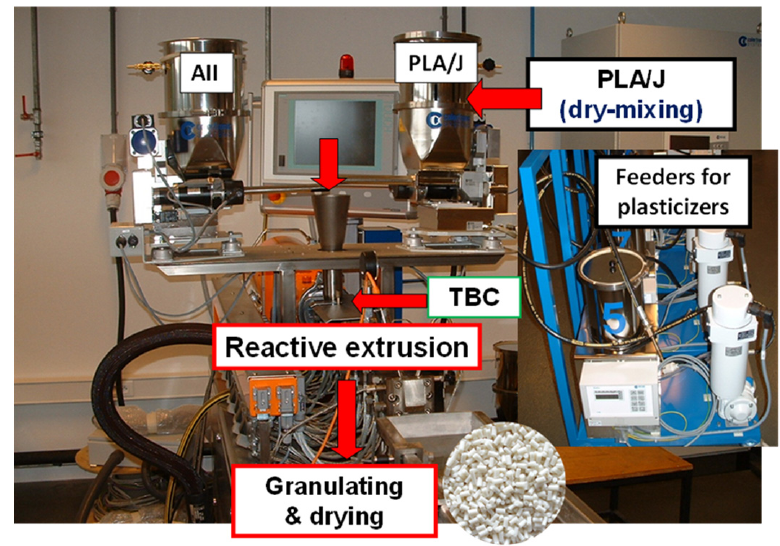
Figure 2. Experimental setup for the production by REX of plasticized PLA/AII composites modified with Joncryl.